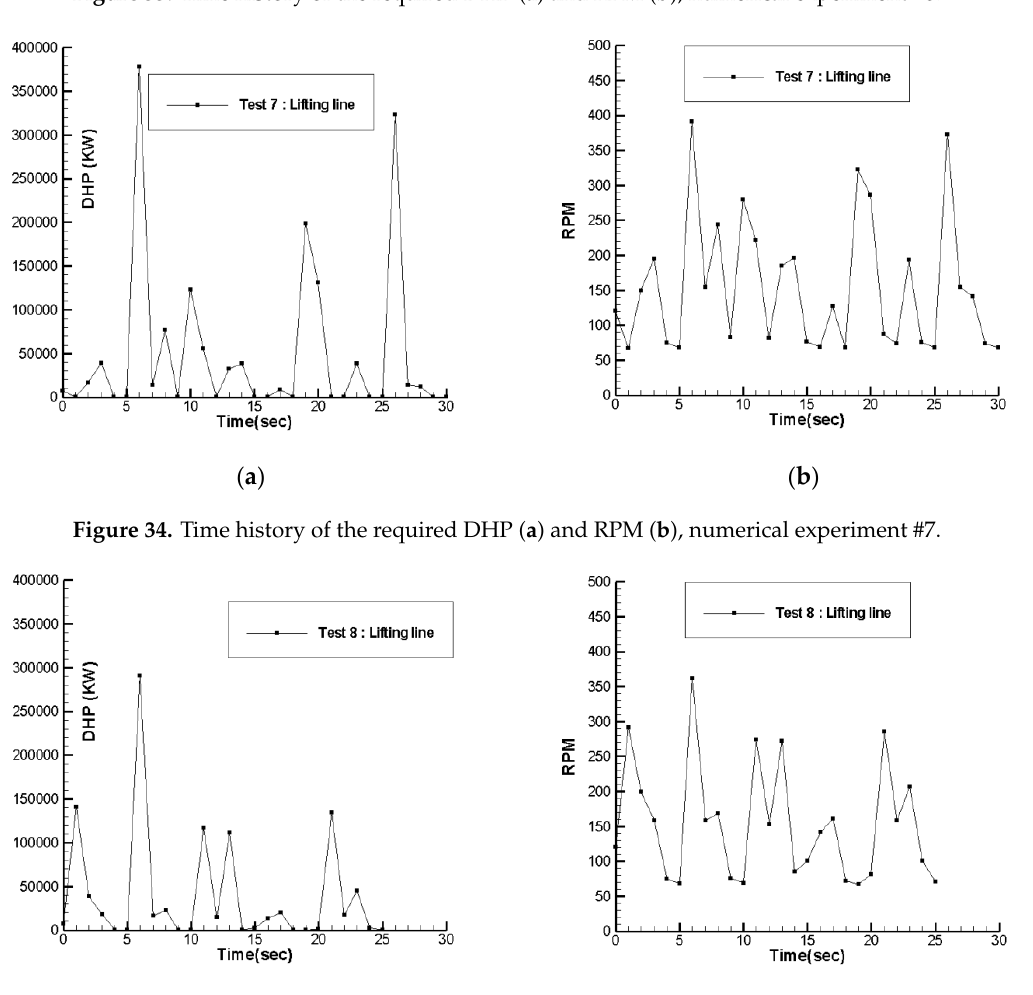
Figure 33. Time history of the required DHP ( a ) and RPM ( b ), numerical experiment #6.